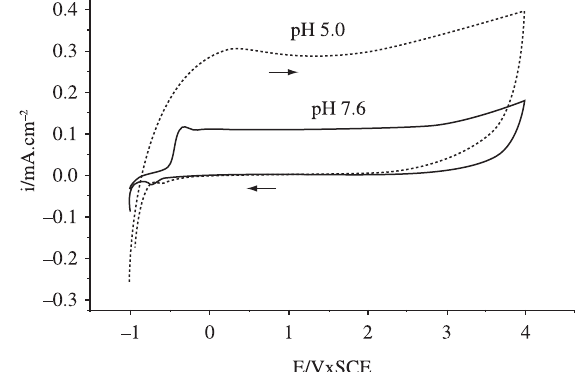
Figure 5. Voltammetric curves of Ti6Al4V in solutions at pH 5.0 and pH 7.6 containing 0.1 M NaF.